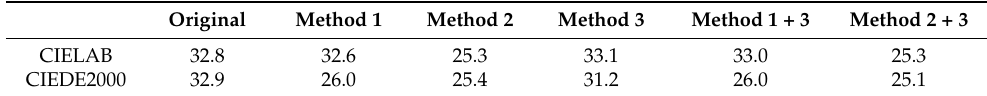
Table 6. The STRESS values of the original and optimized color-difference formulas using the 40 sample pairs in Experiment II.